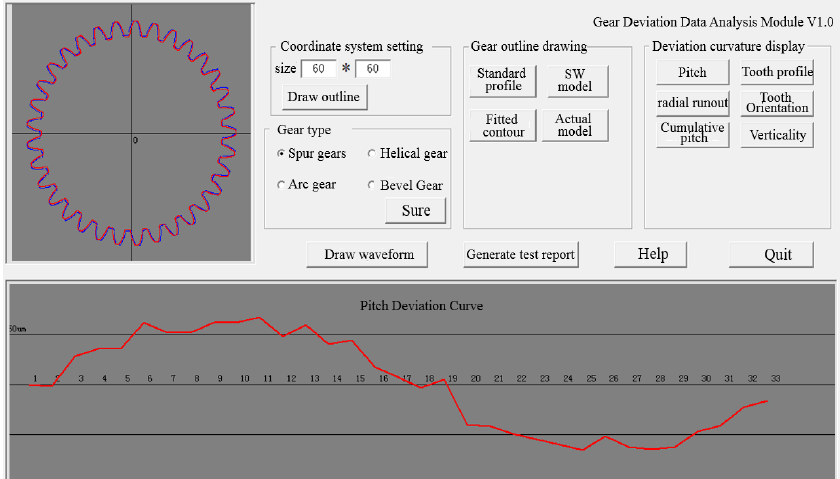
Figure 8. Measurement control and deviation analysis software.